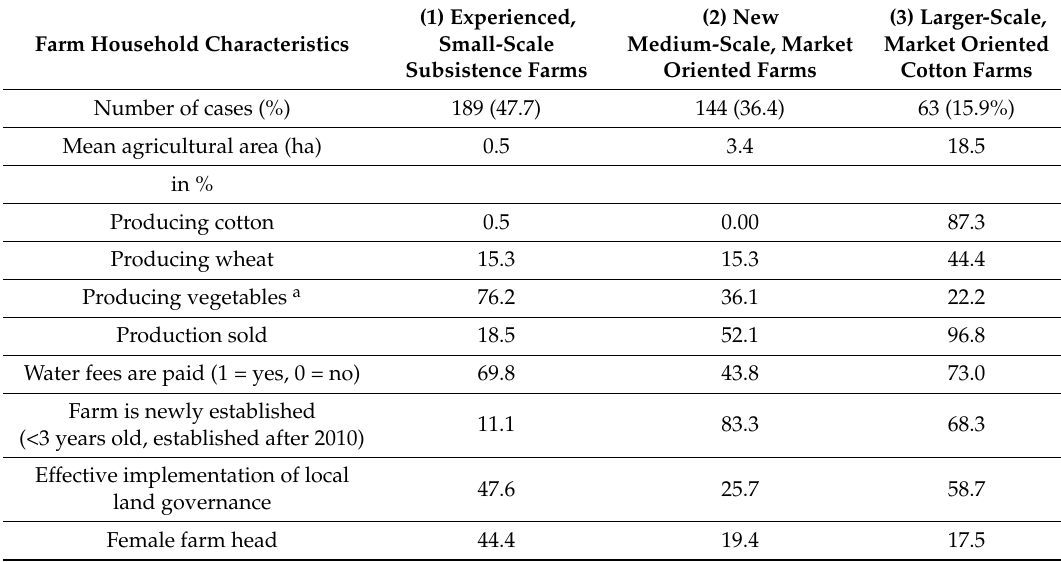
Table 3. Farm types based on cluster